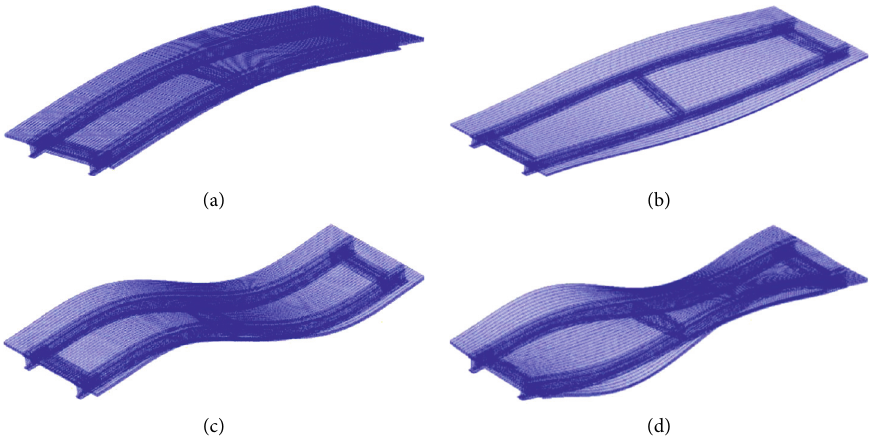
Figure 9: Mode shapes obtained with the FE model predictions. (a) Mode 1. (b) Mode 2. (c) Mode 3. (d) Mode 4. Table 4: Mode frequencies: experimental results vs numerical predictions. Mode no.